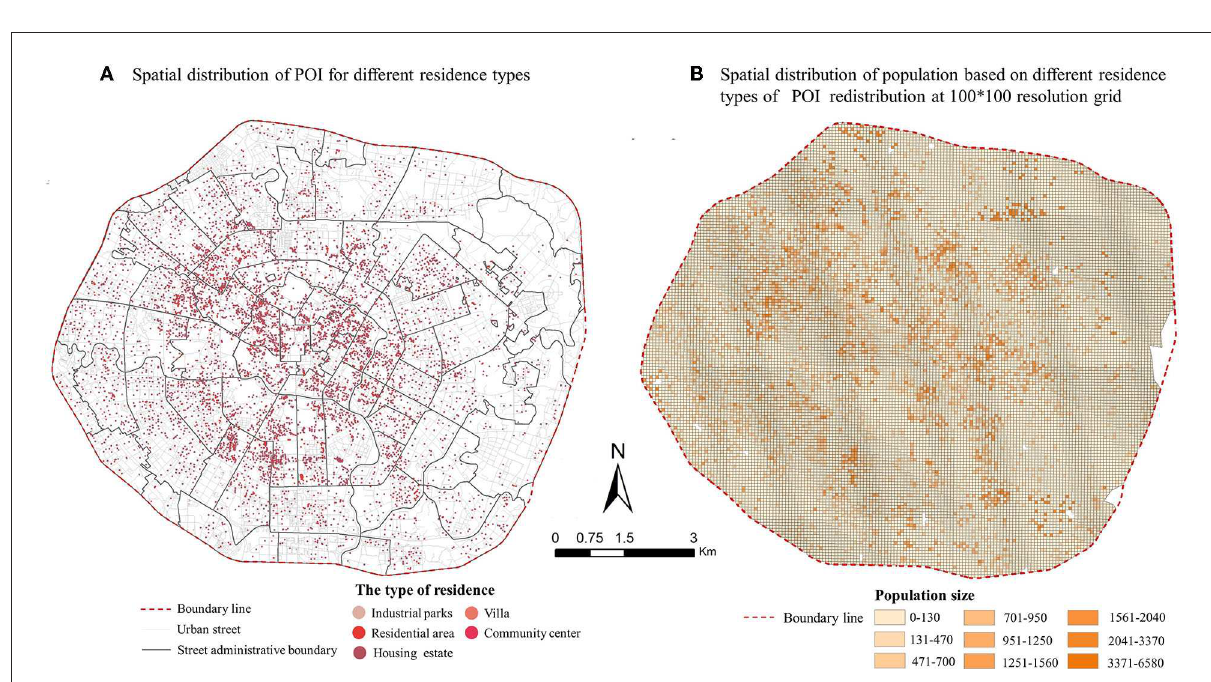
FIGURE4 Spatial distribution of population in Chengdu, China. (A) Spatial distribution of POI for different residence types. (B) Spatial distribution of population based on different residence types of POI redistribution at 100 times 100 resolution